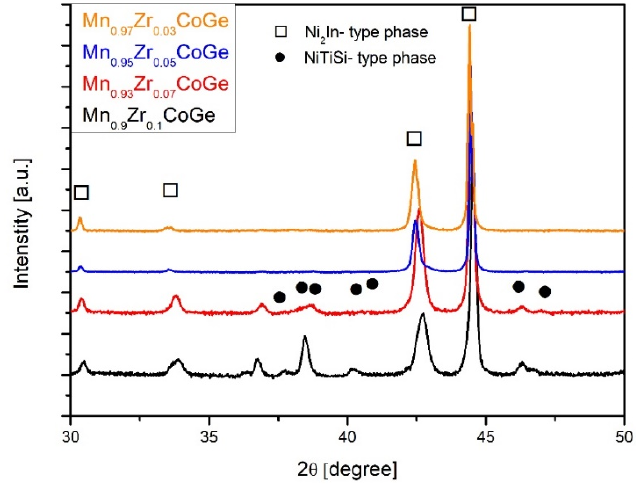
Figure 3. The XRD patterns collected for all studied samples. However, current studies confirmed the results described in [21]. A slight increase of lattice constants is visible with an increase of the Zr content in the alloy composition. Such an effect was expected due to the ionic radius of Zr (r Zr = 1.60 Å) being higher than Mn (r Zr = 1.18 Å), and this causes expansion of the orthorhombic and hexagonal phases. Considering that the orthorhombic structure could be considered as a distorted hexagonal cell [24], an addition of Zr promotes the formation of the NiTiSi-type phase. Deep analysis of the XRD patterns did not detect any additional phase related to an occurrence of impurities. The Rietveld analysis carried out using experimental XRD patterns revealed some slight changes in the lattice constants of recognized phases. The results of the Rietveld refinement were collected in Table